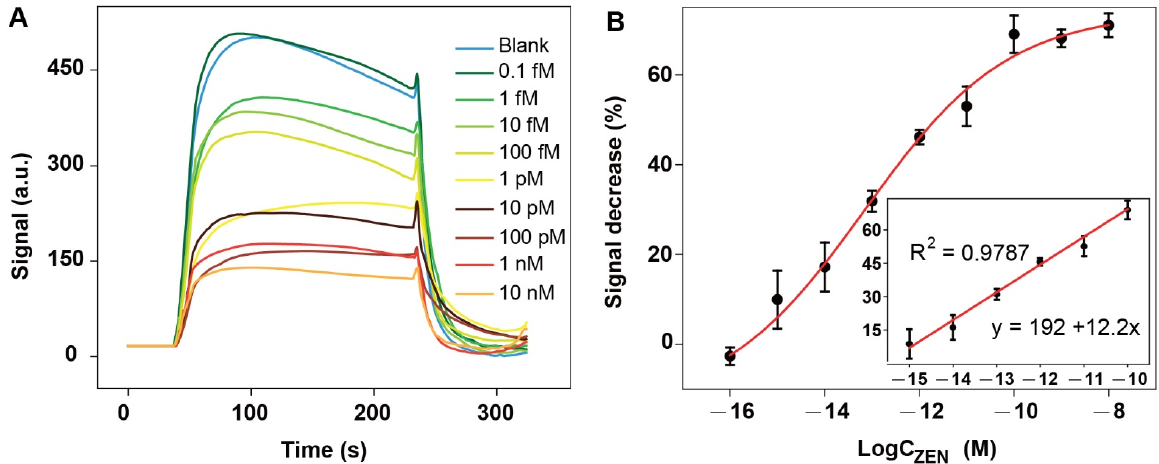
Figure 4. Ultrasensitive detection of ZEN in buffer by NADL-EWOF aptasensor: ( A ) original response curves for the detection of samples containing ZEN at a wide concentration range; ( B ) the titration curve generated according to the signal decrease percentage (S%). The fluorescence intensities used for the calculation of the S% were indicated in ( A ). The error bars in figure ( B ) are the standard deviations derivatized from the three replicates.